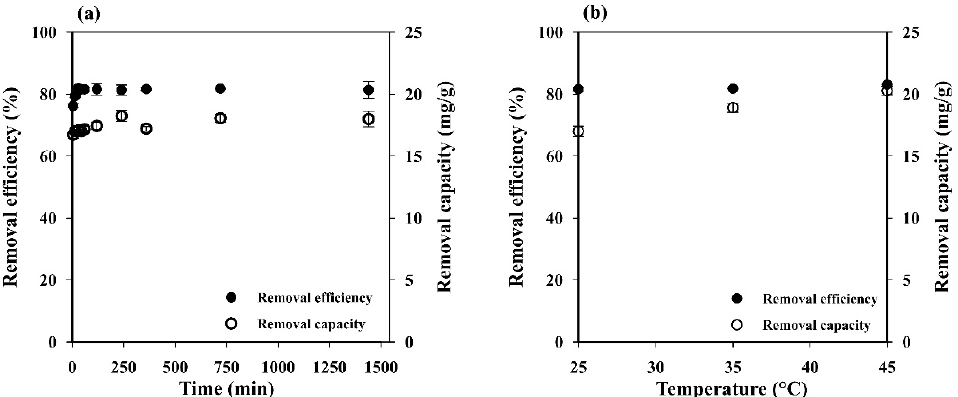
Figure 5. Influence of ( a ) contact time and ( b ) temperature on the MB removal efficiency and capacity of starch cryogel.